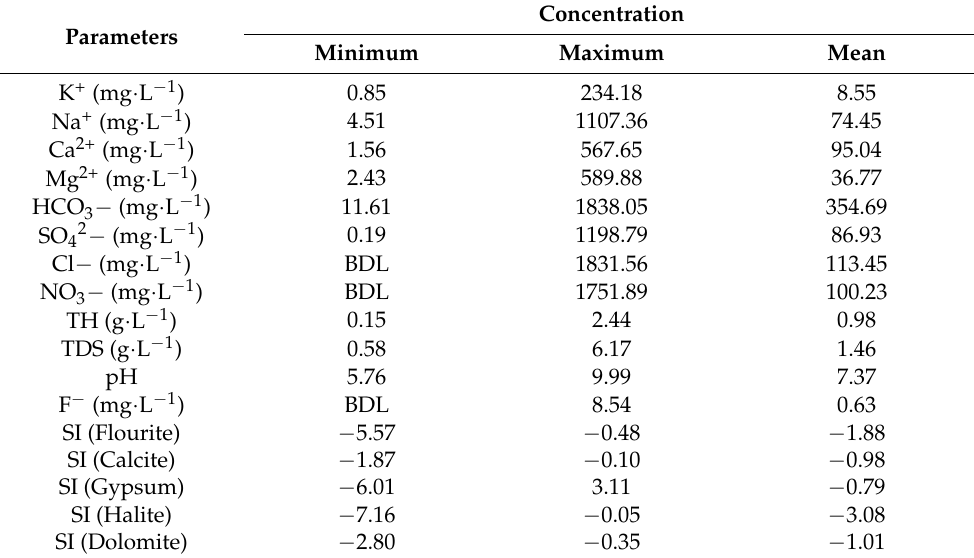
Table 1. Concentrations of hydrochemical parameters and saturation indexes of minerals.